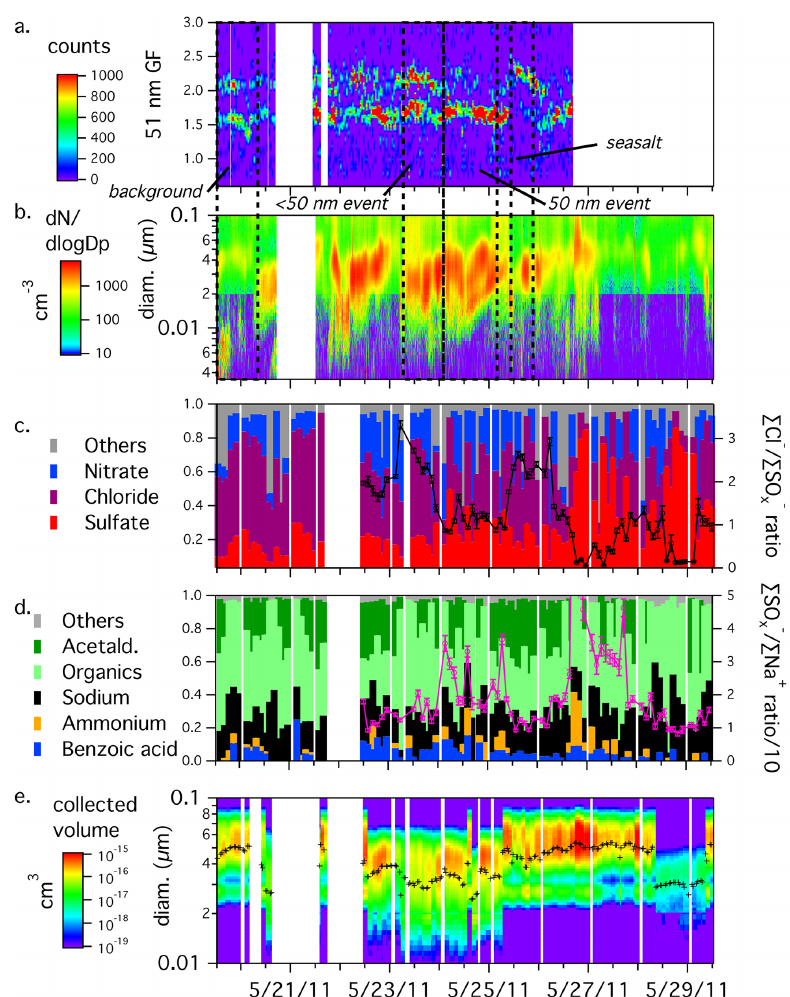
Figure 1. (a) Hygroscopic growth factor for 51nm dry diameter particles. (b) Ambient particle size distribution. (c) Fractional ion type abundance for negative spectra and sum of chloride ions to sum of sulfate ions ratio (black points). (d) Fractional ion type abundance for positive spectra and sulfate to sodium ratio (magenta points, two volcano plume points clipped). (e) Estimated volume of collected aerosol in each size bin (cm − 3 ) and volume mean diameter for each collection (black